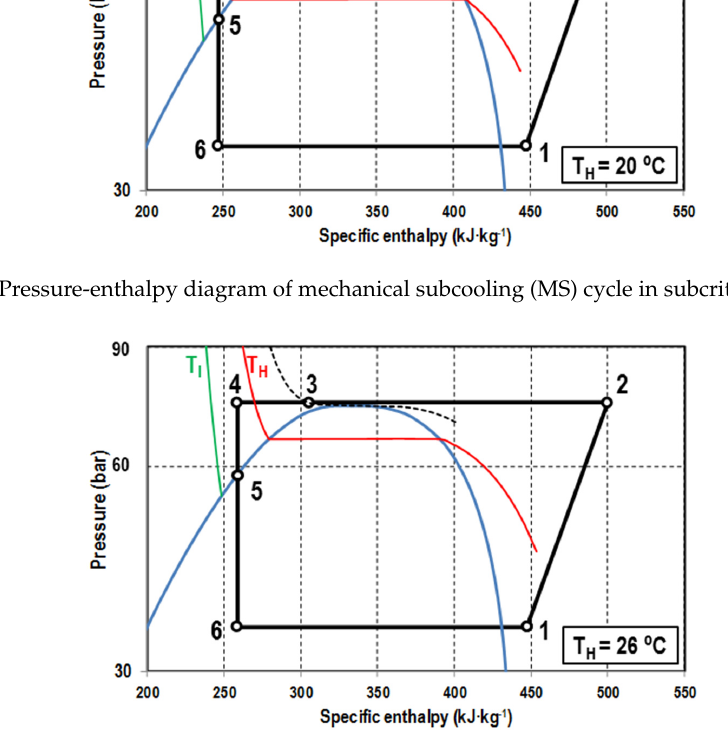
Figure 3. Pressure ‐ enthalpy diagram of MS cycle in transcritical conditions.